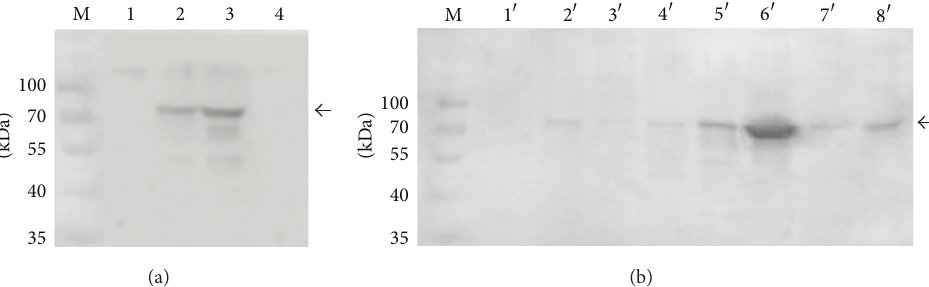
Figure 3: The expression level of sp2 in the developmental stages of the silkworm Bombyx mori (a) and in different tissues of fifth-instar B. mori larva (b). 1: egg; 2: larva; 3: pupa; 4: adult; 1 󸀠 : midgut; 2 󸀠 : the Malpighian tubule; 3 󸀠 : trachea; 4 󸀠 : silk gland; 5 󸀠 : fat body; 6 󸀠 : hemolymph; 7 󸀠 : epidermis; 8 󸀠 : head. The arrow indicates the SP2